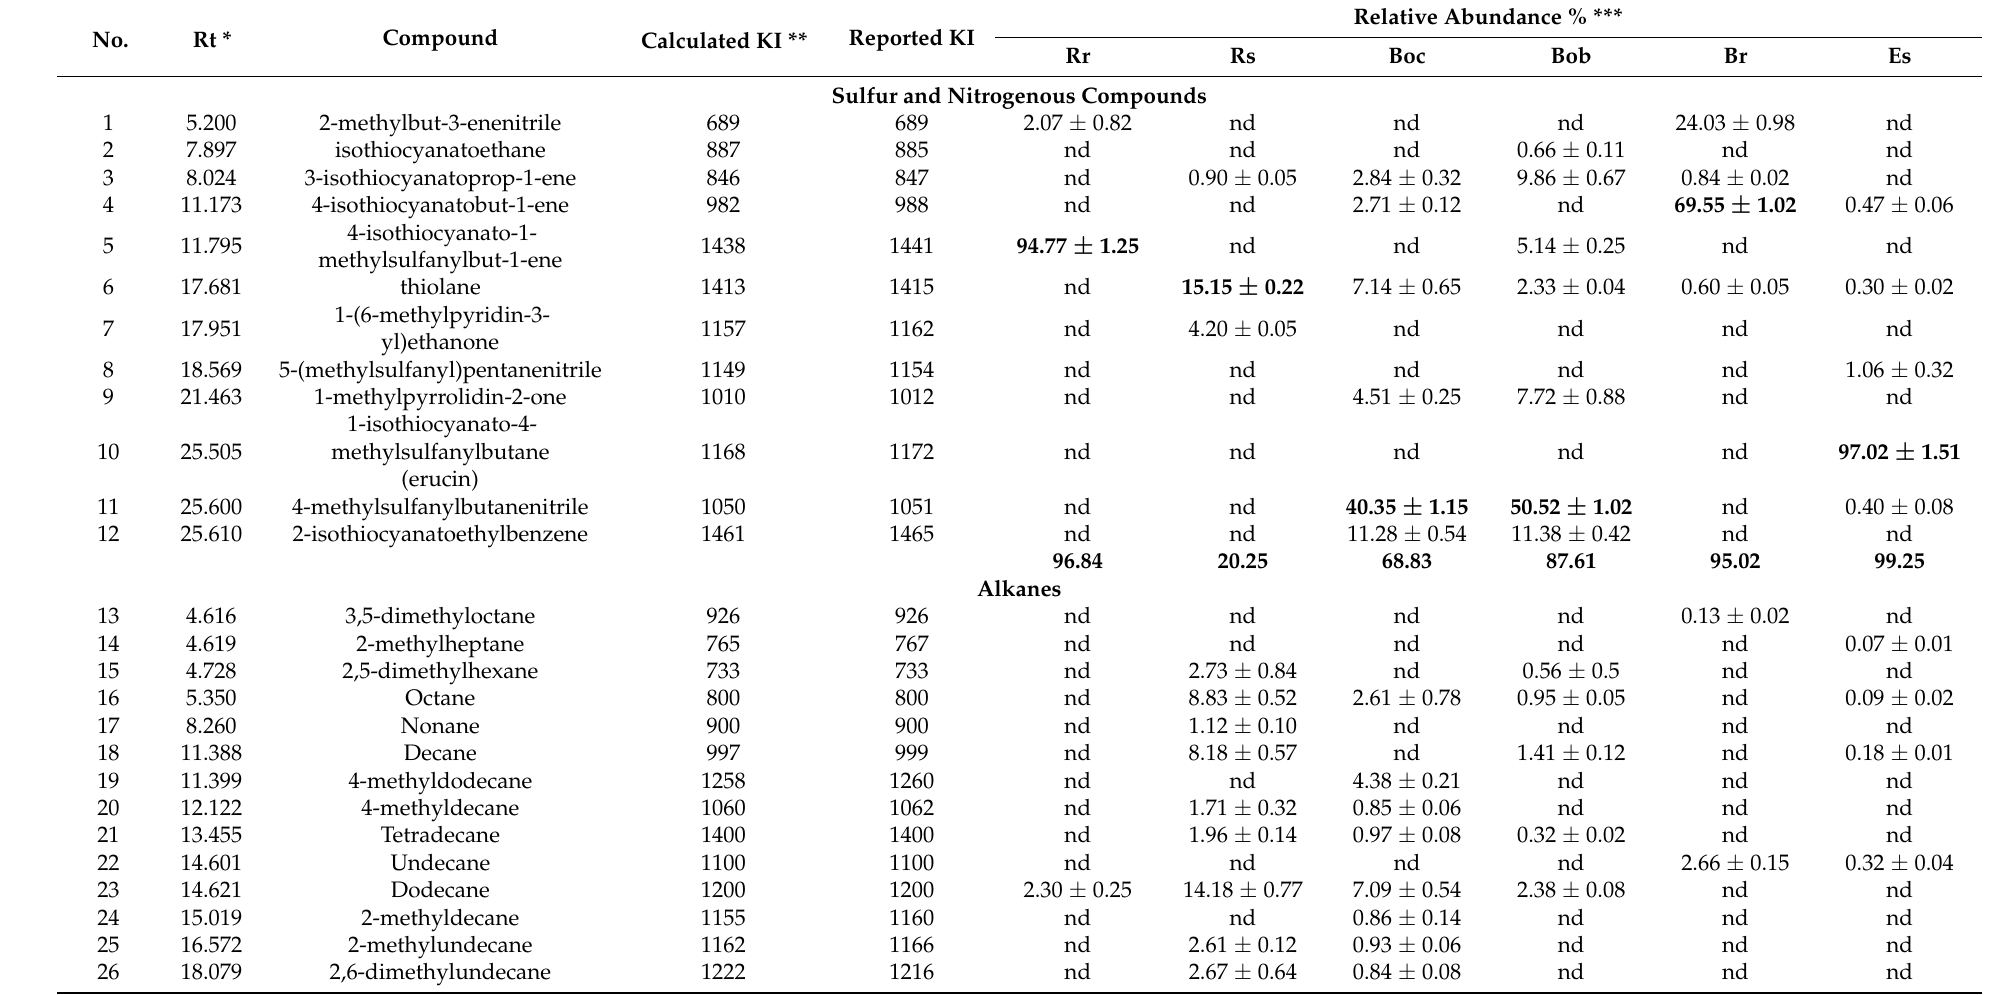
Table 3. GC/MS analysis of volatile oil of Brassicaceae